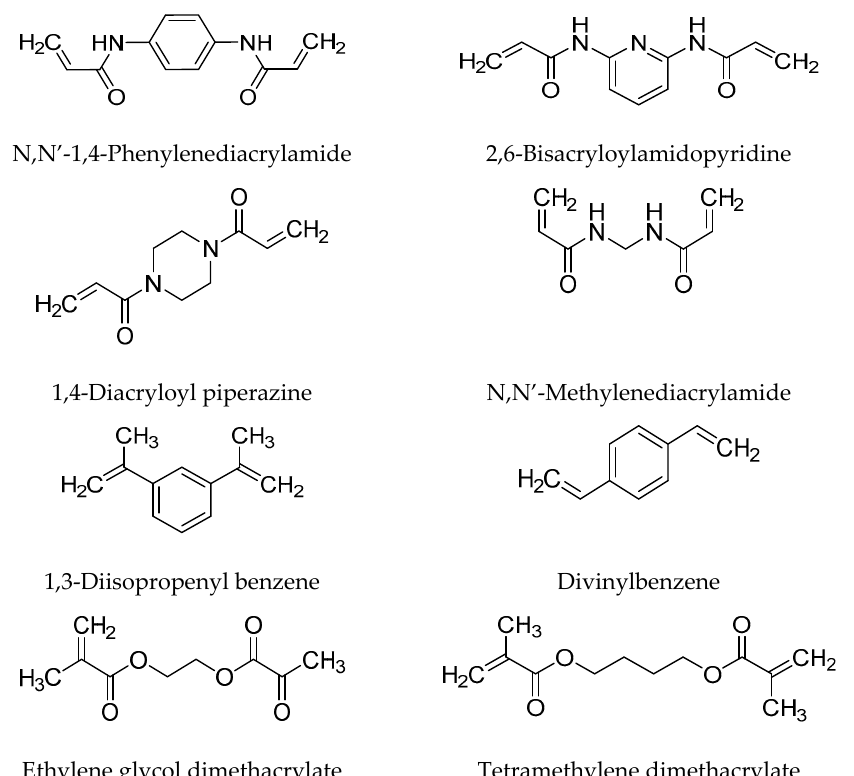
Figure 5. Chemical structures of commonly used cross-linking agents in molecular imprinting technique.